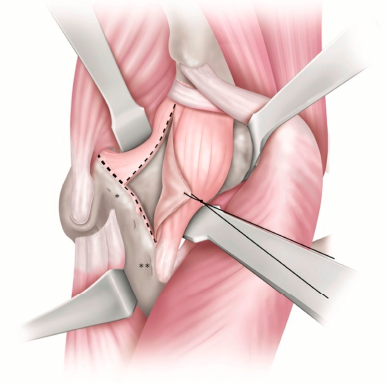
Figure 1. Inverted T-shaped incision of capsular ligament. The capsular attachment between the gluteus minimus (Gmin) and the anterior articular capsule ligament is detached. The inferior band of iliofemoral ligament (IBILFL) is preserved when possible; the inferior band is attached to the medial intertrochanteric eminence. The superior band of iliofemoral ligament (SBILFL) is attached to the lateral intertrochanteric eminence. *: Lateral intertrochanteric eminence **: Medial intertrochanteric eminence.